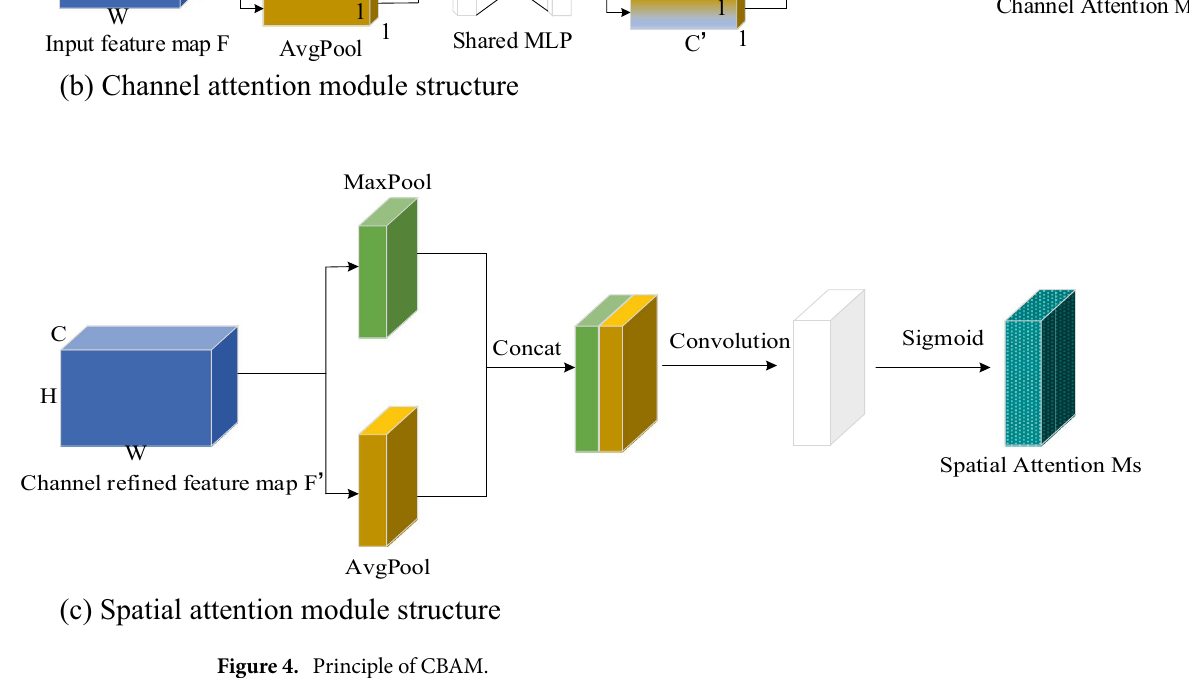
Figure 4. Principle of